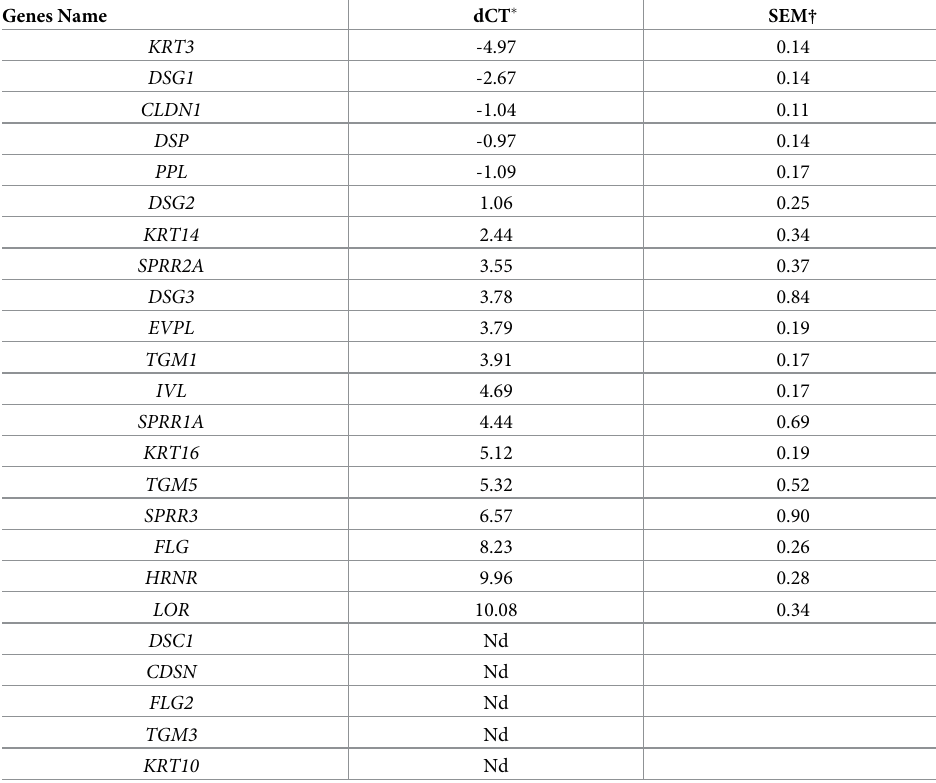
� Mean expression normalized to that of housekeeping genes (geometric mean of UBB , TBB and B2M ). dCT: deltaCycleThreshold. † Standard error to the mean. Nd: not